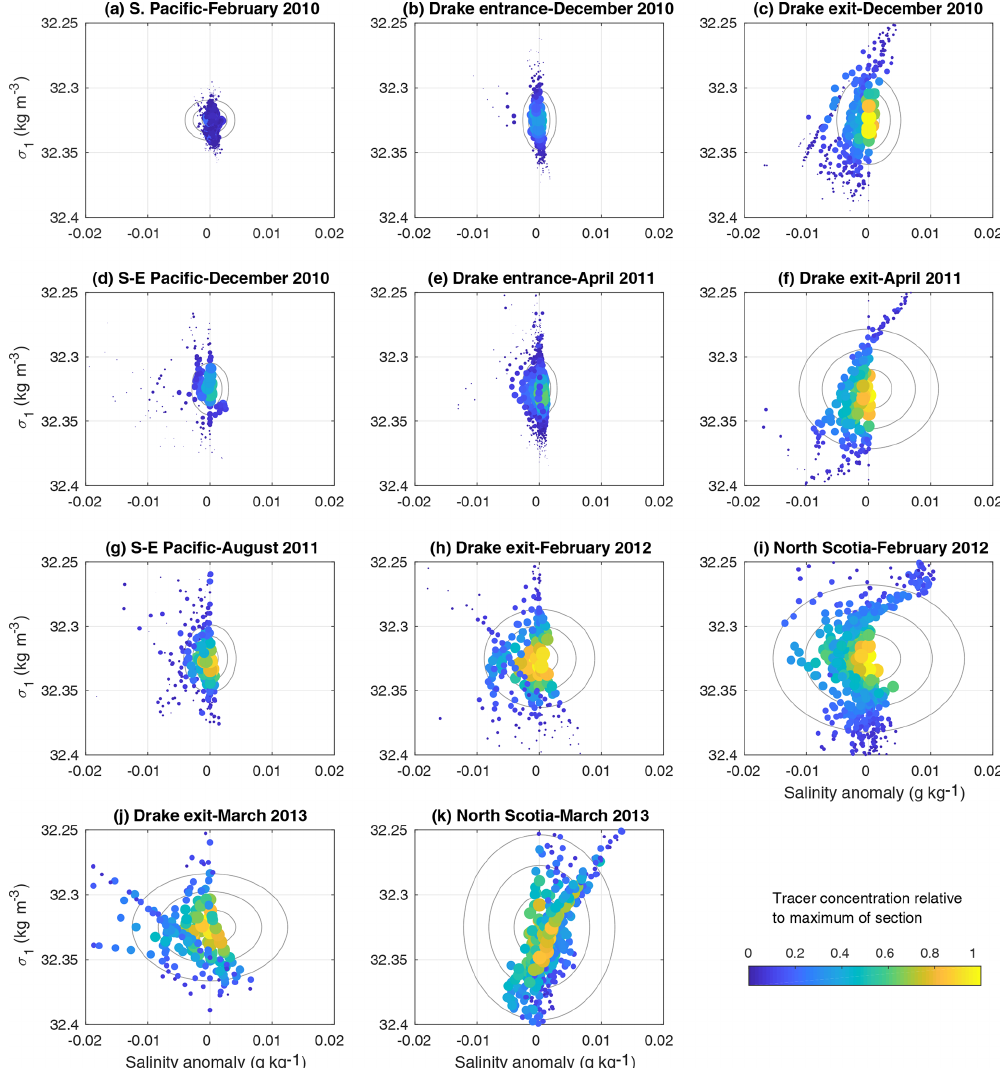
Figure 4. Data from all 11 sections from the five DIMES cruises discussed are shown in potential density-versus-isopycnal-salinity-anomaly coordinates. Each point is coloured by the tracer concentration relative to the maximum of that section (see Fig. 2 for these values). Grey contours show the σ/ 2, σ and 3 σ/ 2 contours of a fit of a 2D Gaussian curve to these